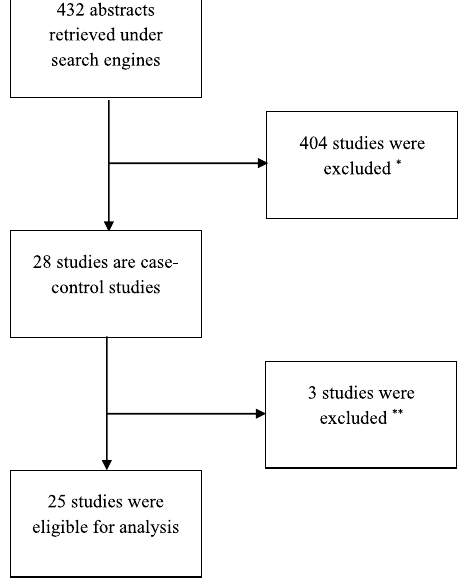
Figure 1. Summary of literature